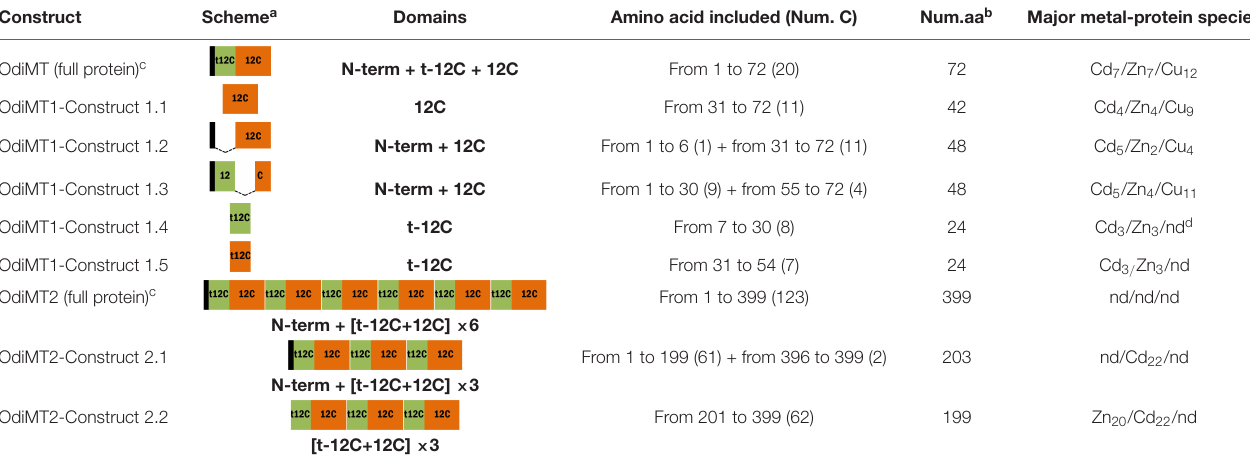
TABLE 1 | Heterogously produced proteins containing different number and combinations of t-12C and 12C domains. Construct Scheme a Domains Amino acid included (Num. C) Num.aa